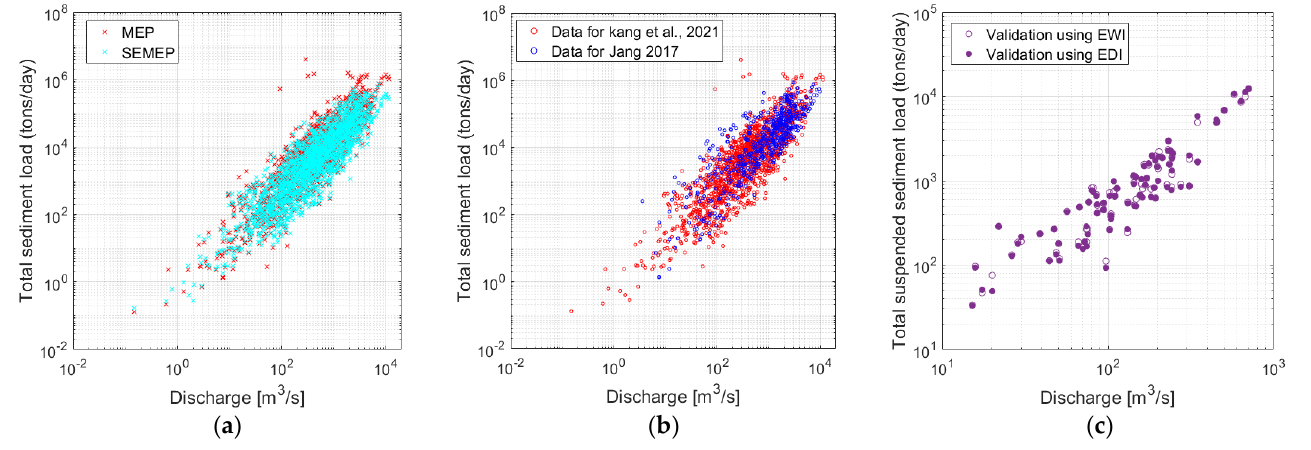
Figure 2. ( a ) Total sediment load based on the modified Einstein’s procedure (MEP) and the series expansion modified Einstein’s procedure (SEMEP) (calibration data for the model by Kang et al. [14]), ( b ) total sediment load for Jang’s model [13], and ( c ) total suspended sediment load of validation data from equal-discharge-increment method (EDI) and the equal-width-increment method